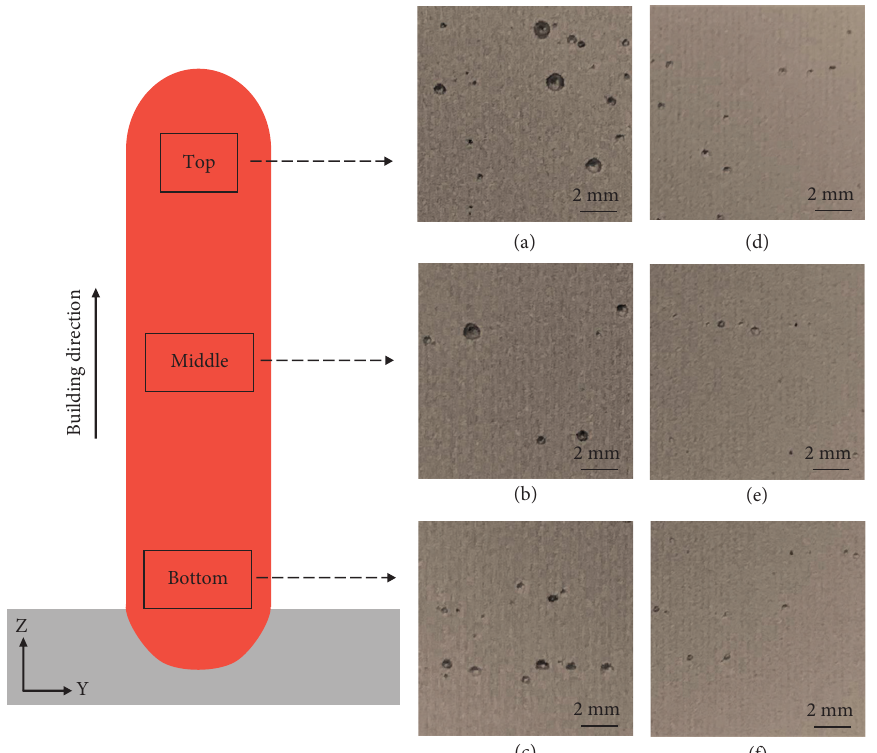
Figure 8: Pore size and distribution on the cross section of the deposition wall: (a)–(c) without the path constraint and (d)–(f) with the copper plates constrained